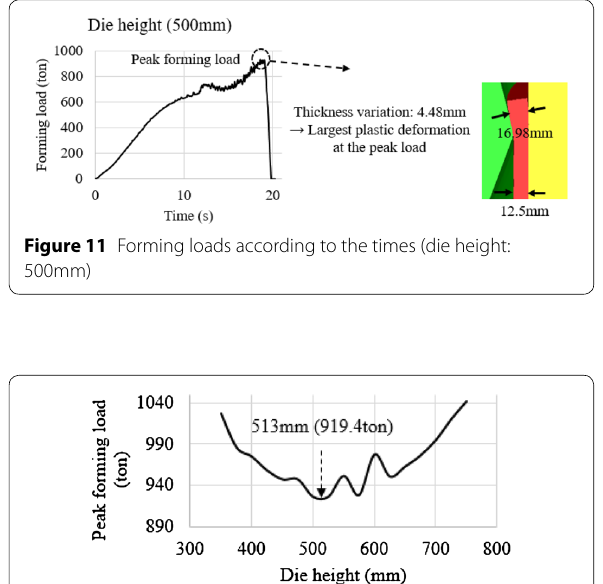
Figure 12 Peak forming load according to the die heights